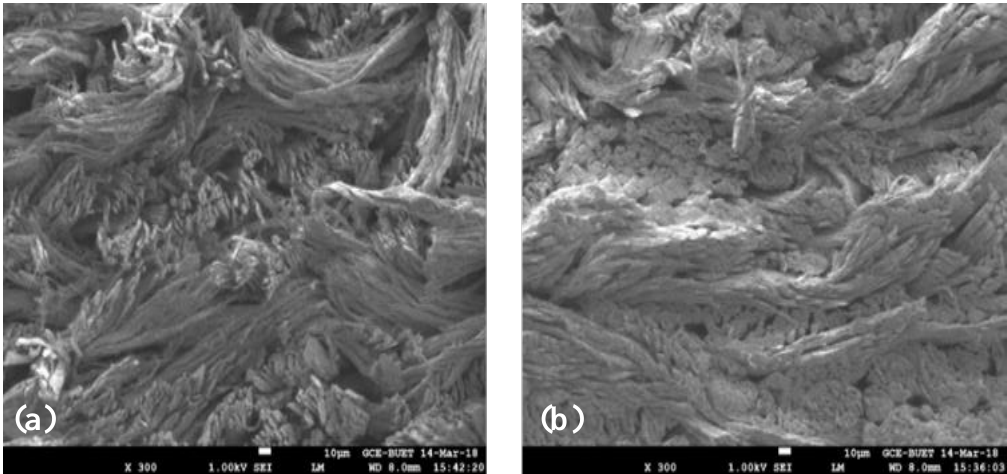
Figure 7. SEM photographs of prepared crust leathers a) control (50% salt) and b) experimental (20% leaf paste) of